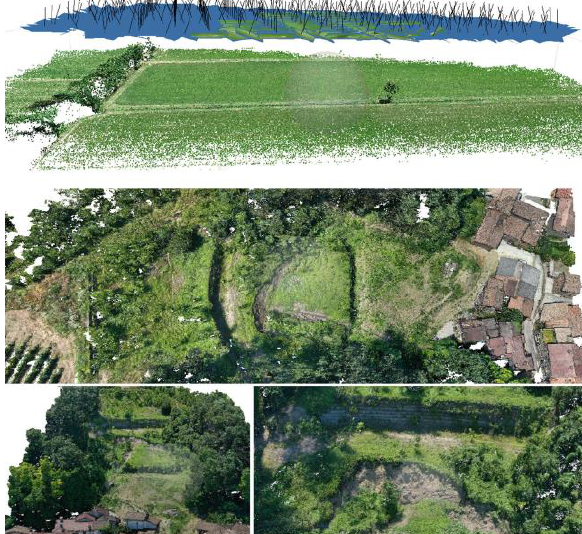
Figure 1 . Images of the two case studies analysed in this phase of the ongoing research: above, plain of Pavia in Po valley; below, Oltrepo’ Pavese landslide.